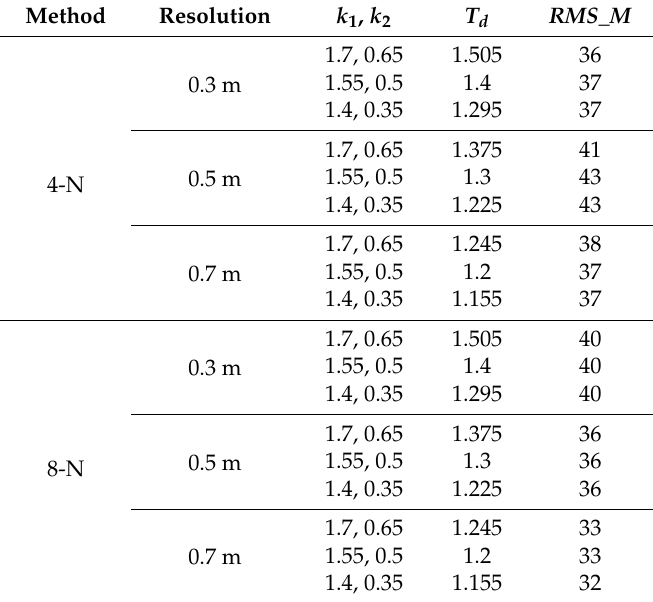
Table 4. Effects of different parameters on the matching results in single-tree detection. Method